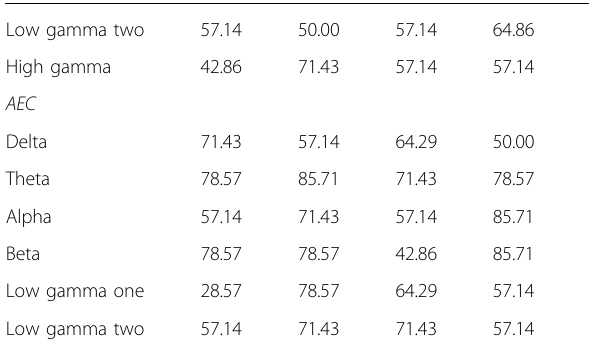
Table 1 A. SVM modelling CV per participant group accuracy (%, mean ± SD); B. SVM modelling fi nal model per participant group accuracy (%) on holdout test